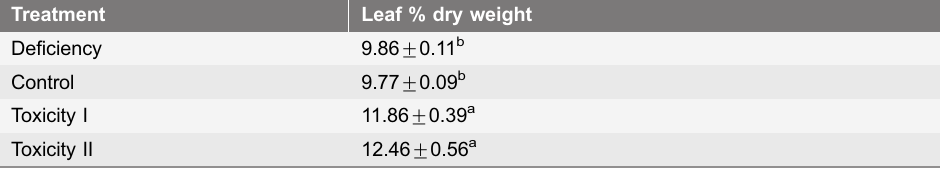
Table 3. Leaf % dry weight of barley plants grown with varying Mn supplies. Data are means ¡ SE (n 5 3).